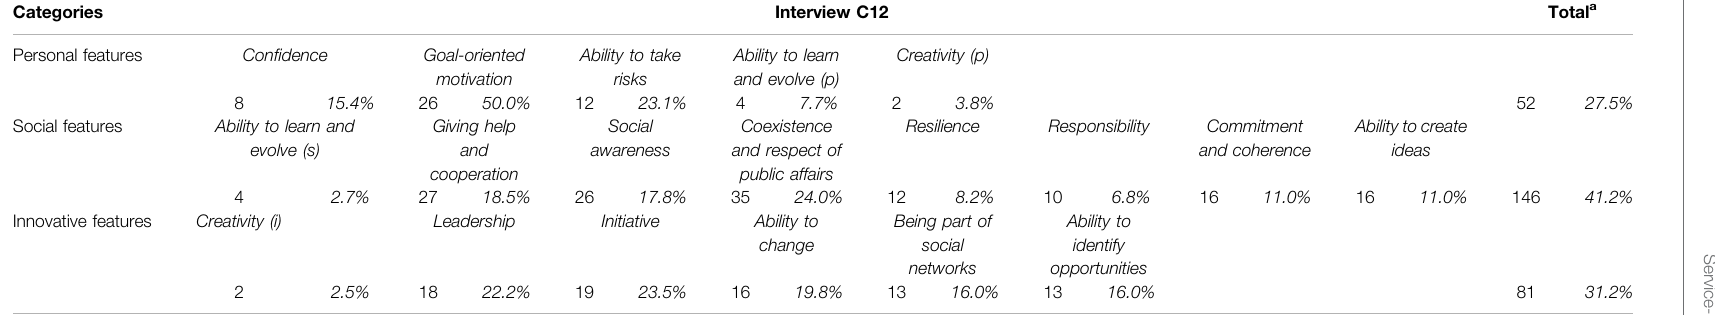
TABLE 7 | Quotes of Social Entrepreneurship features on interview